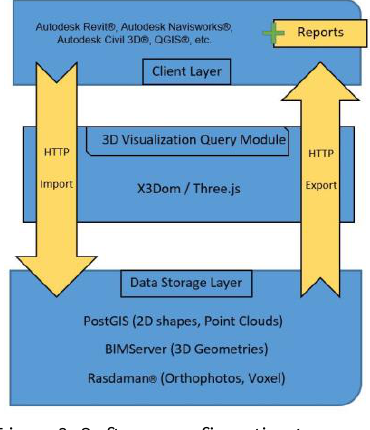
Figure 3. Software configuration to